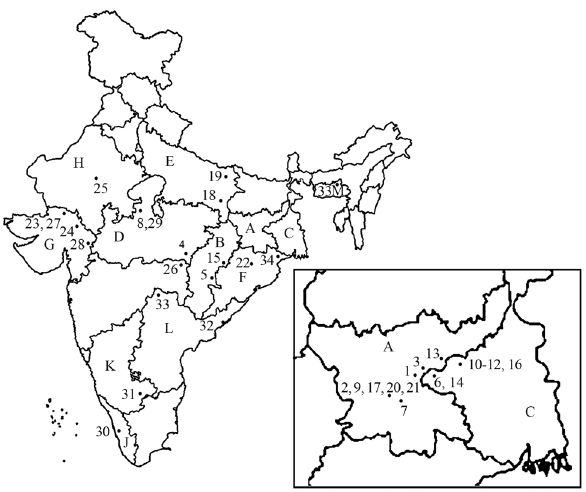
Figure 1 - Map of India, showing State boundaries, collection sites of the cultivated lines, and geographic races of K. lacca and other species of